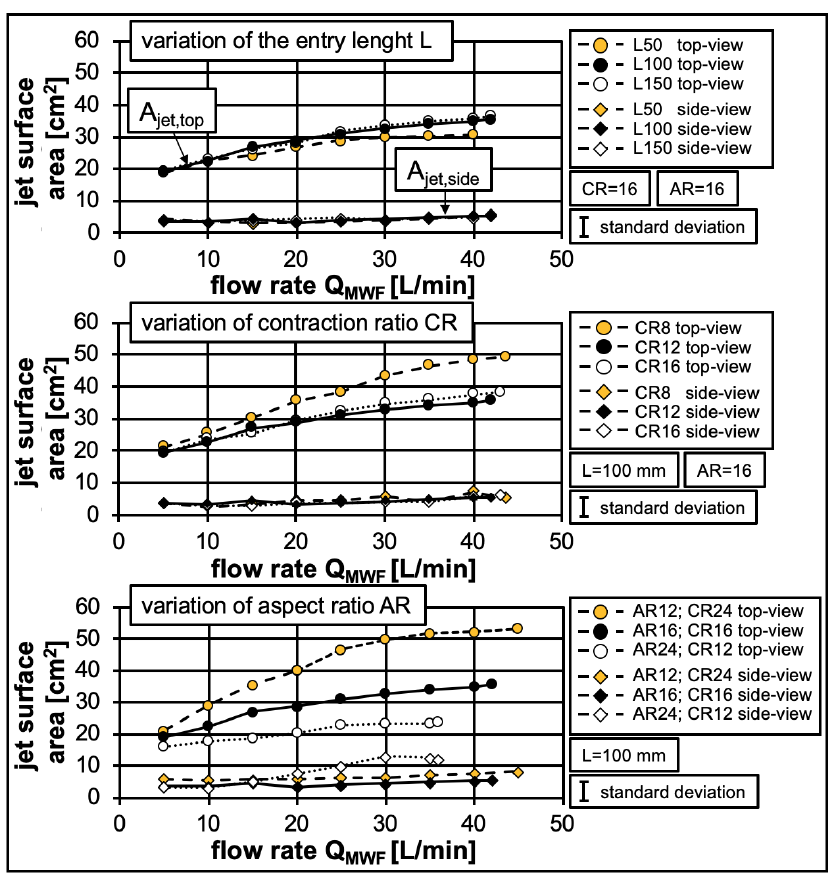
Figure 8. Jet expansion over the flow rate with variation of the entry length, contraction ratio, and aspect ratio.